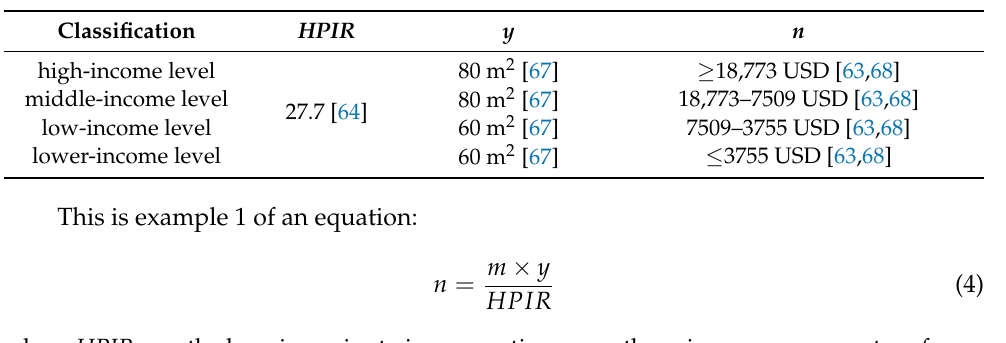
Table 2. The classification standard of income level.